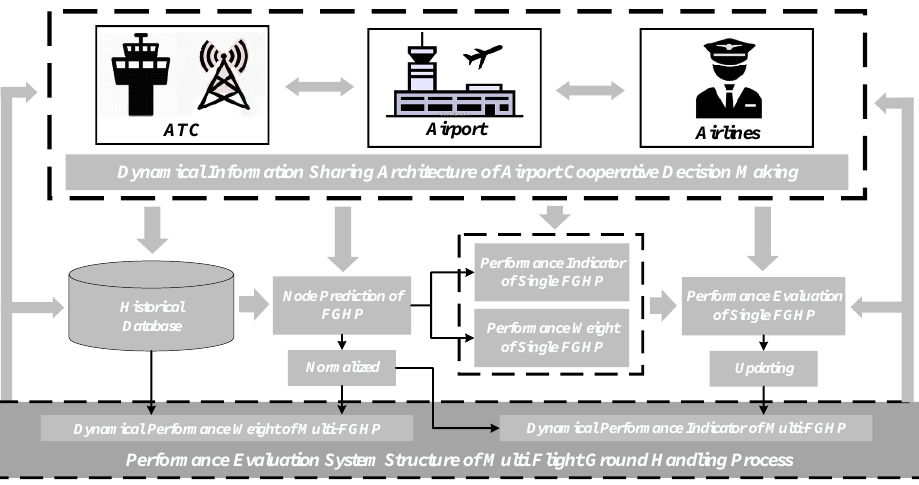
Figure 3. Multi-FGHP performance evaluation system structure.